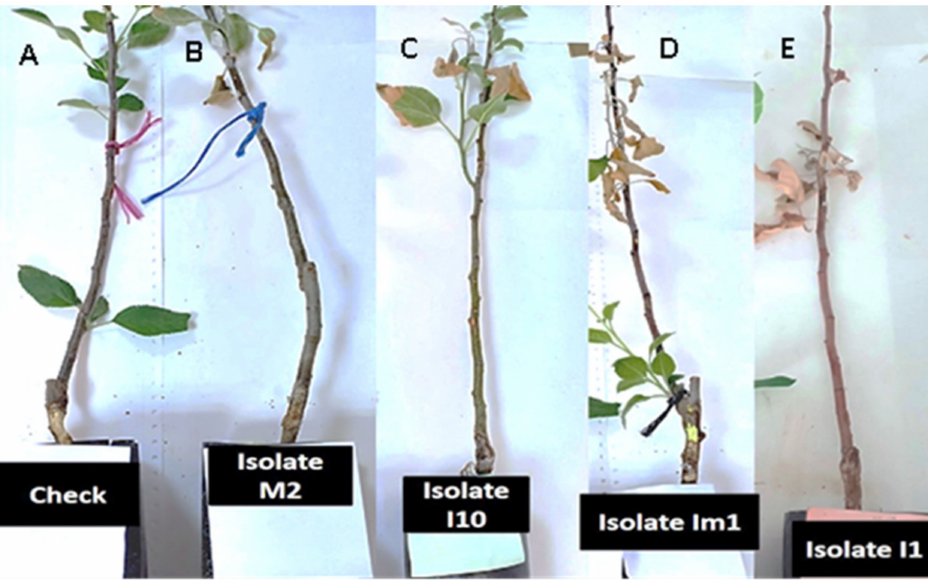
Figure 6. Symptoms of yellowing, wilting, and lesions on stems of apple rootstock M115 seedlings at the end of the stem pathogenicity test: healthy control (( A ), uninoculated plants); plants inoculated with Phytopythium vexans M2 ( B ), Pp. vexans I10 ( C ), Pp. vexans Im1 ( D ), and Pp. vexans I1 ( E